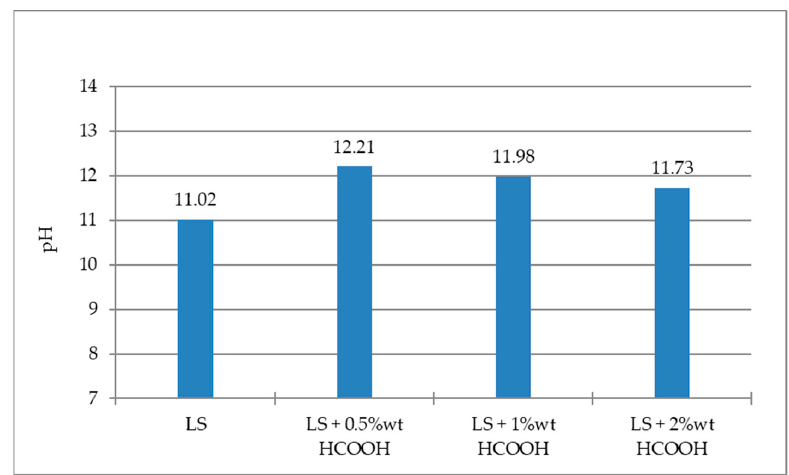
Figure 7. The pH in the washing bottle after flue gas cleaning.